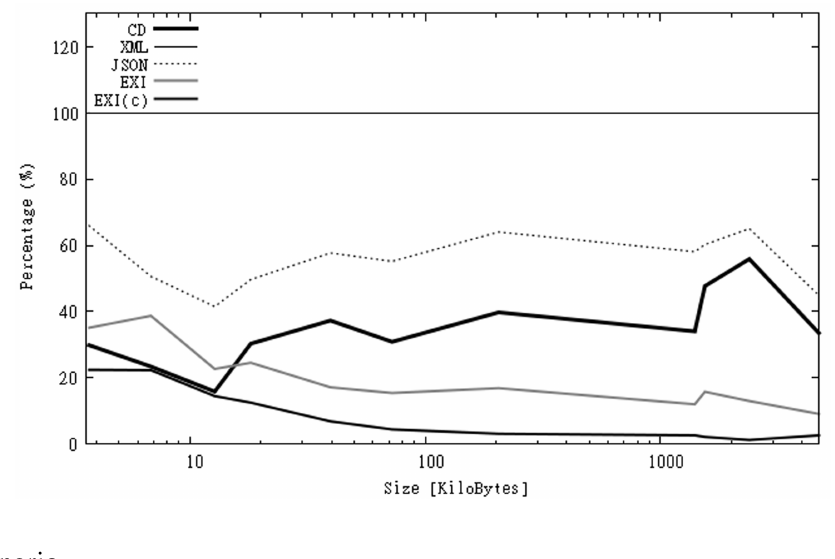
Figure 1. Percentage of size of capabilities files using different